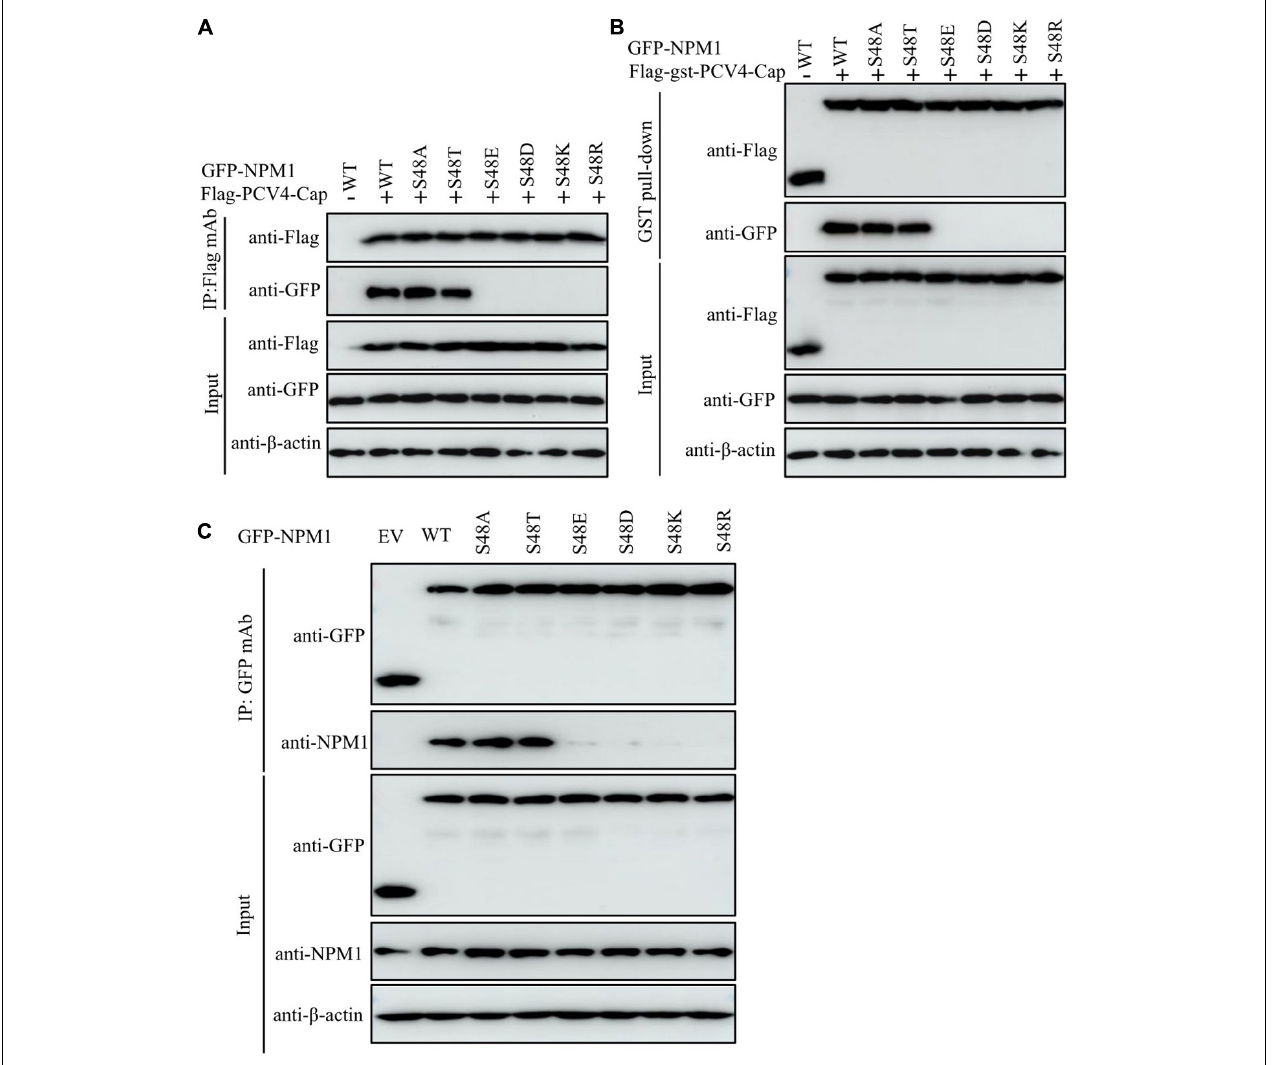
FIGURE 5 | The serine-48 charge property of NPM1 determines its oligomerization and NPM1/Cap interaction. (A,B) The serine-48 charge property of NPM1 is essential for interaction with PCV4 Cap. HEK293T cells were co-transfected with NPM1 or NPM1 mutant plasmids (NPM1-S48A, NPM1-S48D, NPM1-S48E, NPM1-S48K, NPM1-S48R, or NPM1-S48T), together with the Flag-PCV4-Cap or Flag-gst-PCV4-Cap plasmid, and the cell lysate extracts were immunoprecipitated or subjected to GST pull-down assay followed by western blotting using the indicated antibodies. (C) Charged amino acids replaced by serine-48 disrupted